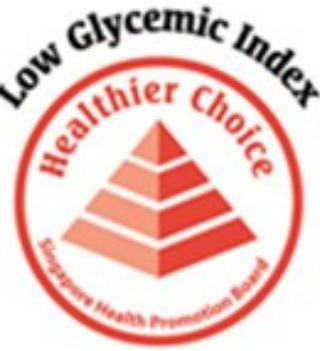
Figure 3. Singapore’s Healthier Choice symbol with the low Glycaemic Index claim.